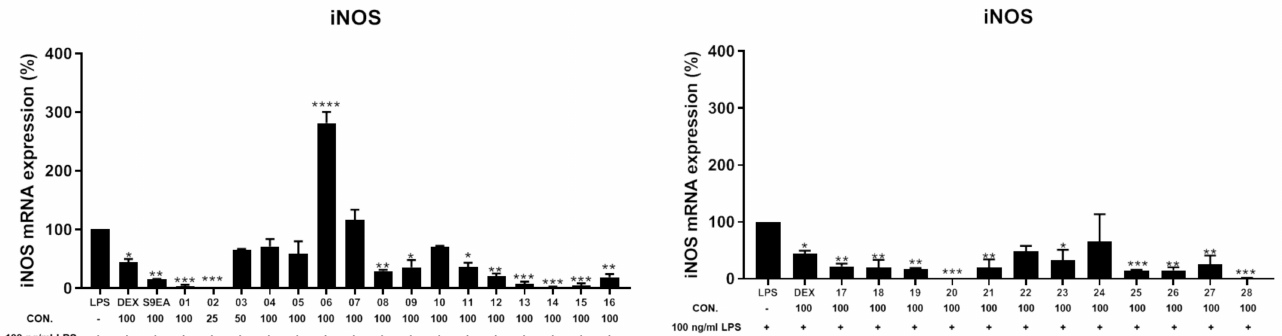
Figure 12. The inhibitory effect of 1 – 28 on LPS-induced iNOS mRNA expression in dendritic cells by the RT-PCR analysis. The values are mean SEM ( n = 3); * p < 0.05, ** p < 0.01, *** p < 0.001, **** p < 0.0001 compared with the LPS alone stimulated group. The relative intensity of the LPS alone stimulated group was taken as 100%. The bar chart shows the results of the EtOAc extract of soft coral Cespitularia sp. (S9-EA) at 100 µ g/mL and compounds 1 – 28 (25–100 µ M) toward iNOS mRNA